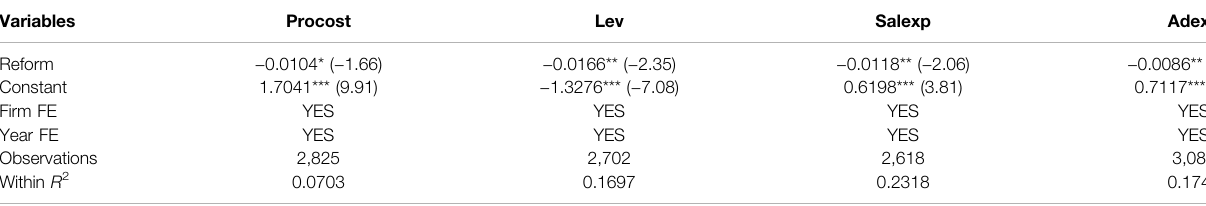
TABLE 8 | Results of the path test.